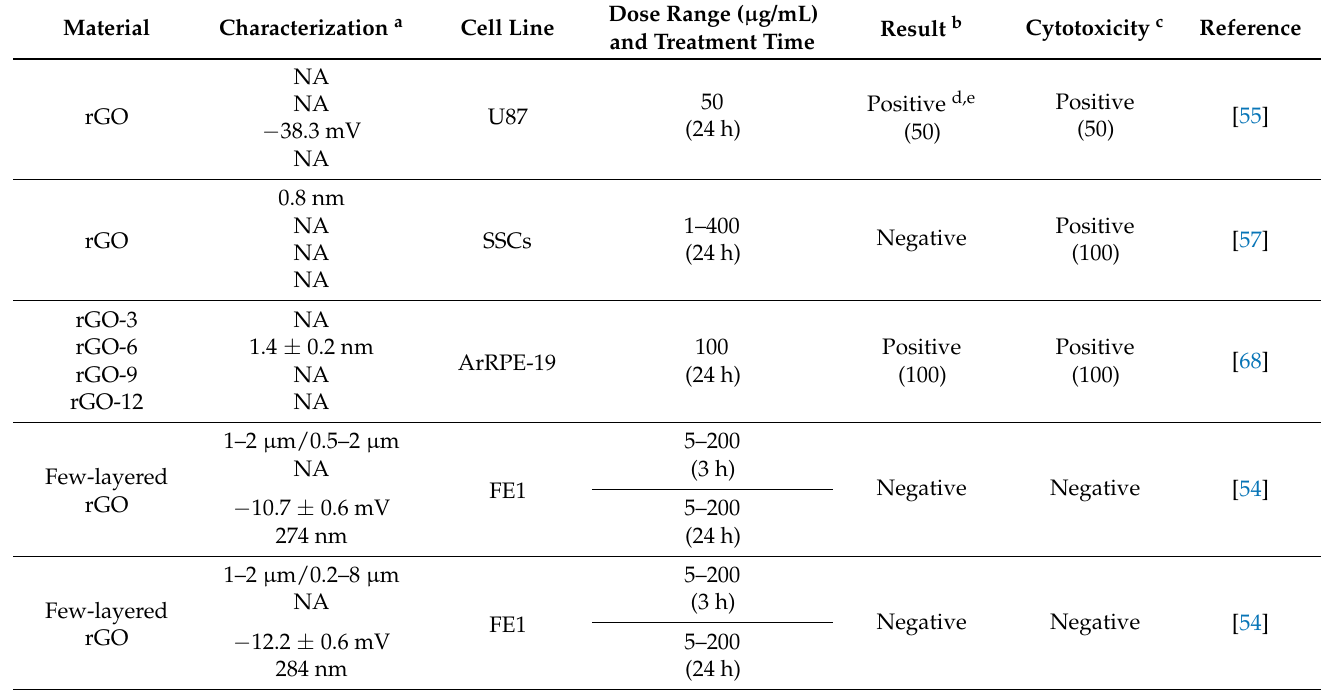
Table 5. In vitro studies assessing the genotoxicity of reduced graphene oxide (rGO) and rGO-related materials rGOs using the comet